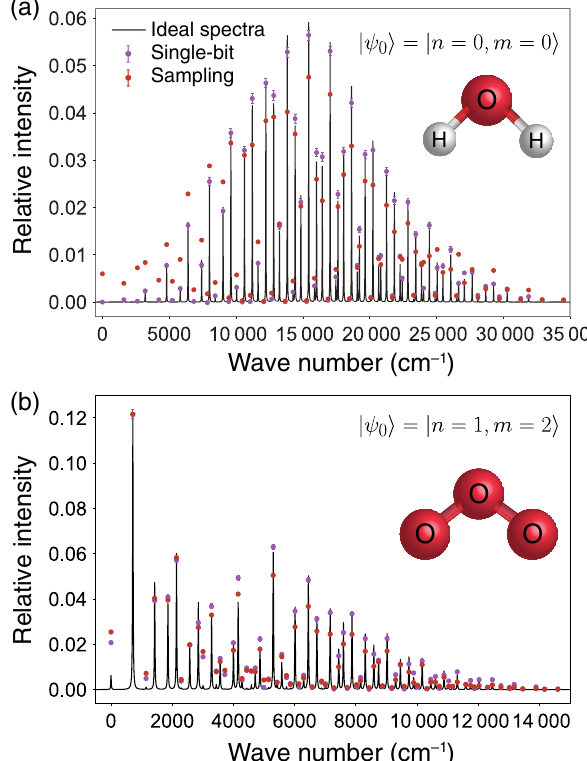
FIG. 3. Experimental Franck-Condon factors. Measured data for ˜ B 2 B 2 Þ excited state of the (a) photoionization of water to the ð ν ˜ B 2 H 2 O þ ð B 2 Þ þ e − starting in the vacuum (vibra- cation H 2 O → h tionless, n ¼ 0 , m ¼ 0 ) state and (b) the photodetachment of the ozone anion to the ground state of the neutral species ν O − 3 → h O 3 þ e − starting from a vibrational eigenstate possessing one quantum of symmetric-stretching and two quanta of bending excitation ( n ¼ 1 , m ¼ 2 ). The abscissa scale corresponds to vibrational term values (energies in cm − 1 ) within the final (post- transition) electronic PES calculated from the harmonic frequen- cies for symmetric-stretching and bending degrees of freedom: ˜ ν ¼ n 0 ˜ ν 0 . Solid lines depict theoretical FCFs, arti- þ m 0 ˜ ν 0 stretch bend ficially broadened with Lorentzian profiles ( 10 cm − 1 FWHM). Circles represent experimental data using the single-bit extraction (purple) andsampling(red)measurement schemes explained in the main text; statistical error bars for the latter measurement are not visible on this scale (see Supplemental Material [30]). Systematic errors associated with transmon decoherence during the selective π pulses are corrected for (see Appendix E). Additional errors are present in the sampled values, owing to decoherence effects during the binary decomposition measurement